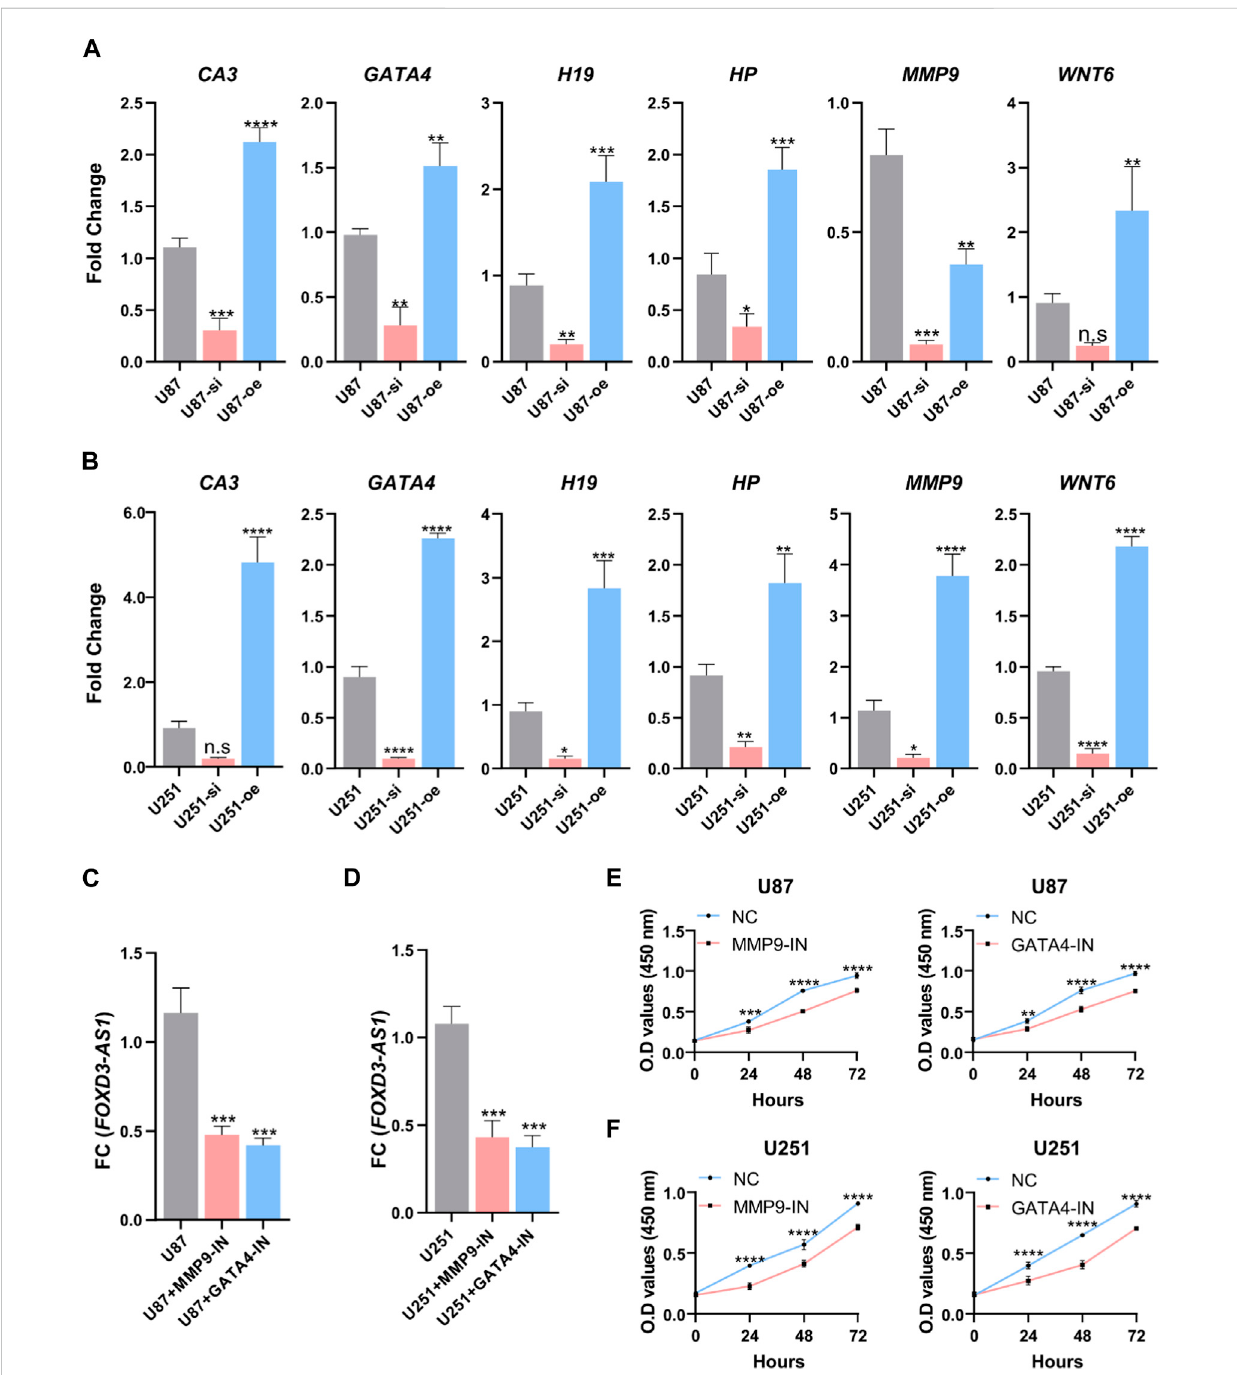
FIGURE 16 FOXD3-AS1 is associated with oxidative stress in U87 and U251 cell lines. (A) RT-PCR was performed to detect and relatively quantify the expression of CA3 , GATA4 , H19 , HP , MMP9 ,and WNT6 associatedwithoxidativestressintheU87cellline. (B) RT-PCRwasperformedtodetectandrelativelyquantify the expression of CA3 , GATA4 , H19 , HP , MMP9 , and WNT6 associated with oxidative stress in the U251 cell line. (C, D) The expression of FOXD3-AS1 was detectedandquanti fi edbyinterferingwiththeoxidativestresspathwayinU87andU251celllinesusinginhibitors. (E,F) Cellularactivitywasdetected and quanti fi ed by interfering with the oxidative stress pathway in U87 and U251 cell lines using inhibitors. n.s P (cid:1) 0.05, ** p ≤ 0.01, *** p ≤ 0.001, **** p ≤